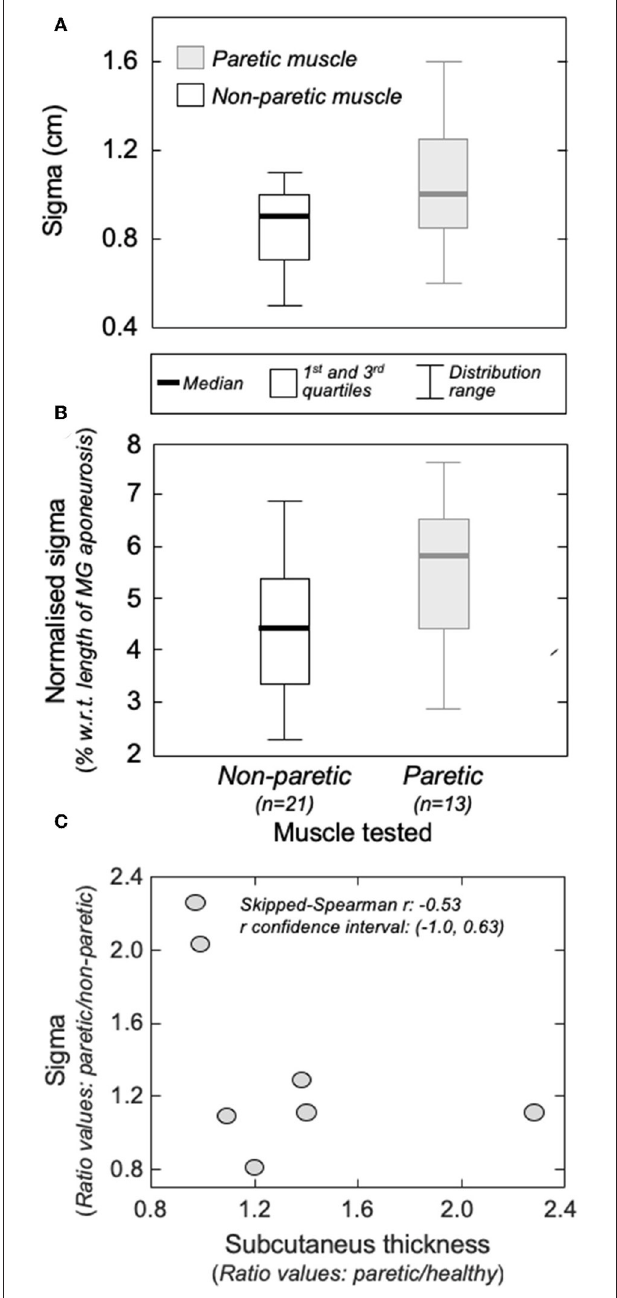
FIGURE 5 | The amplitude distribution of surface, action potentials. (A) shows the standard deviation ( sigma ) of the Gaussian curves fitted to the RMS distribution of motor unit action potentials identified from the non-paretic (white boxes) and from the paretic (gray boxes) MG muscles. Sigma values normalized with respect to the length of the MG superficial aponeurosis (see Figure 1B ) are shown in (B) . Thick horizontal lines denote the median values. Boxes and whiskers correspond, respectively, to the interquartile interval and the range values. Ratios between sigma values obtained from the paretic and non-paretic MG (ordinate) and ratios between subcutaneous thickness values computed for the paretic and non-paretic limb (abscissa) are shown in (C) . The skipped-Spearman correlation coefficient and its confidence interval (23) are shown within (C)